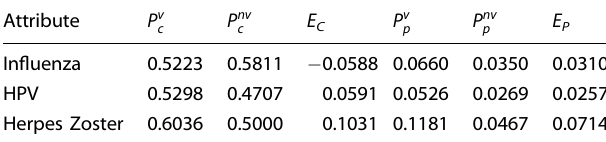
Table 6. Change in click probability and future search